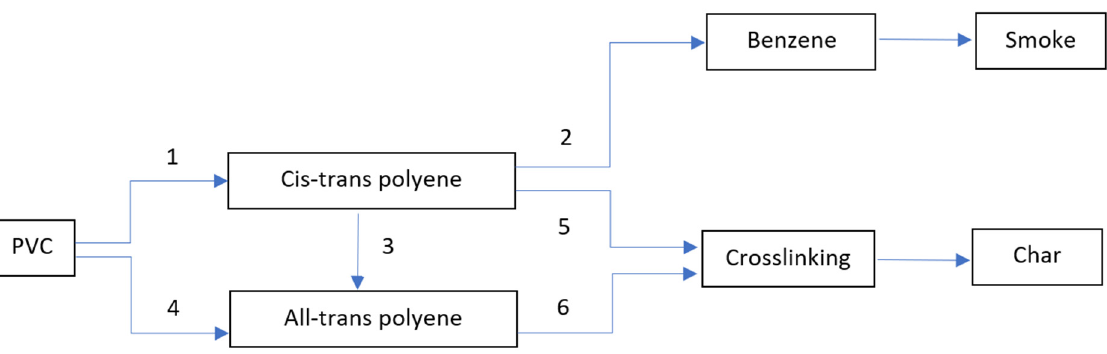
Figure 1. Pathways bringing to char and smoke in PVC